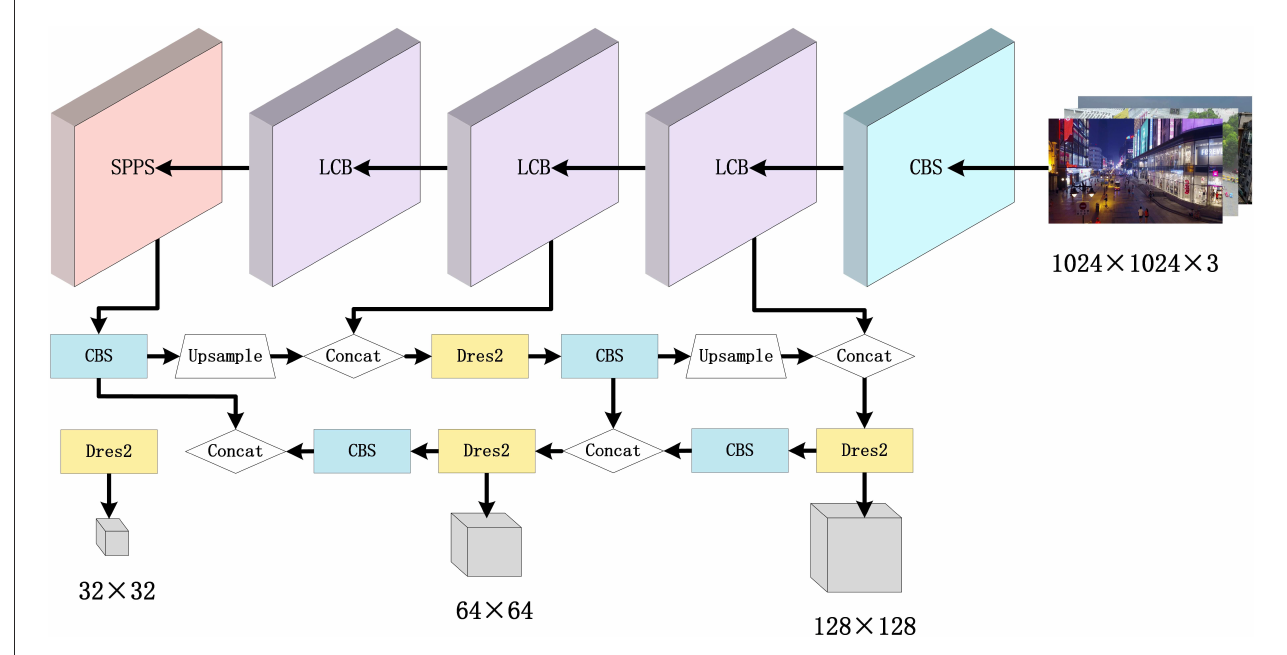
FIGURE2 The architecture of the developed LCB-YOLOv5s.